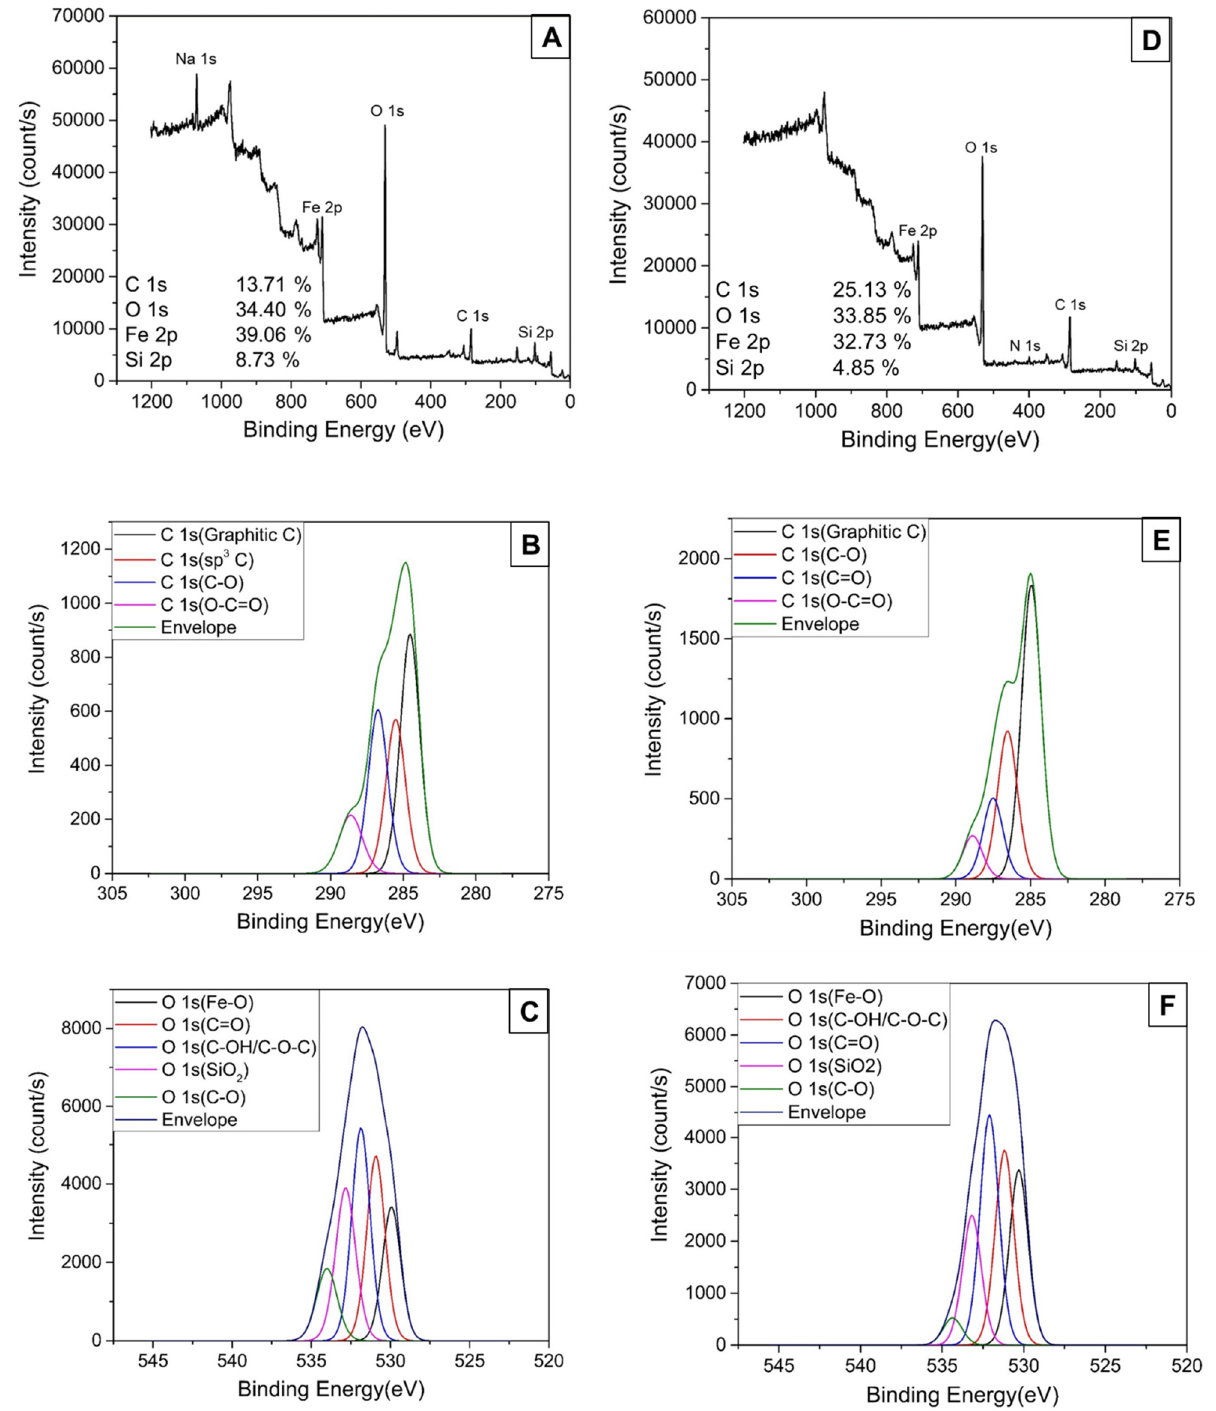
Figure 3. ( A ) The wide-scan XPS, ( B , C ) high-resolution C 1s and O 1s spectra of fresh MBGA2-1 ( D ) The wide-scan XPS, ( E , F ) high-resolution C 1s and O 1s spectra of MBGA2-1 after 4 cycles using 0.1 M NaOH as eluent. 0.1 M NaOH as